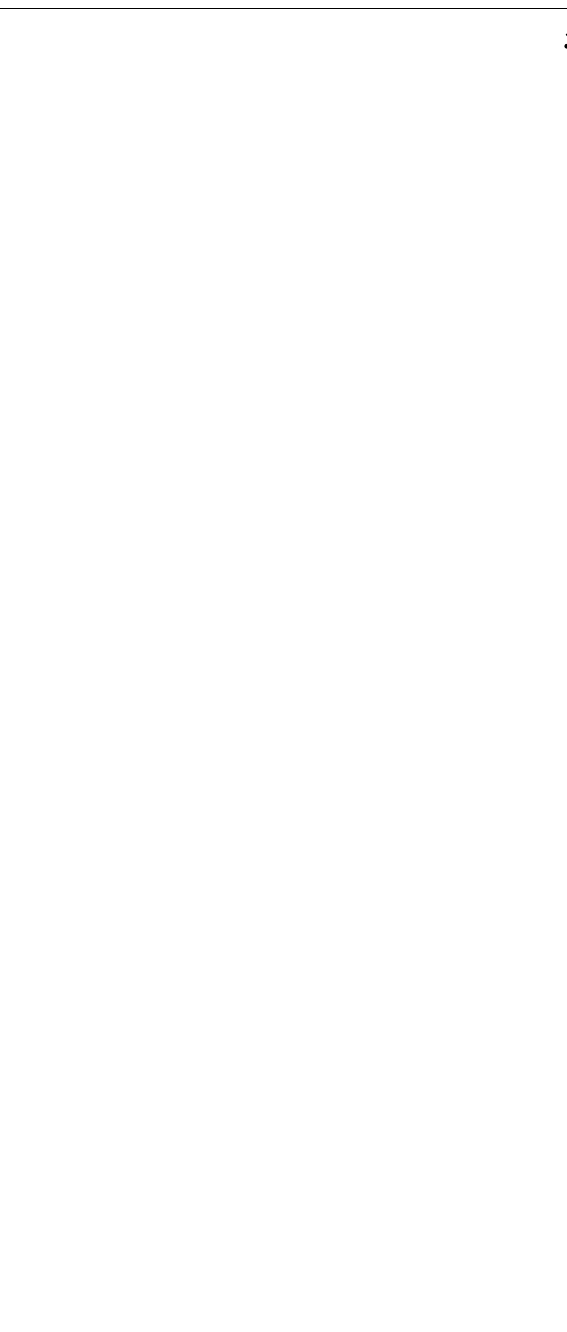
7 South African Journal of Science